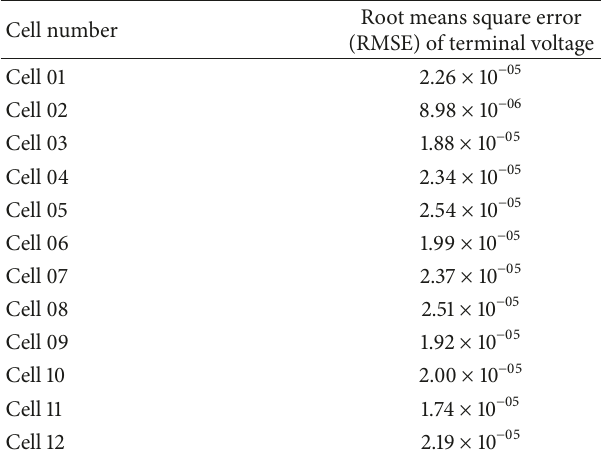
Table 2: RMSE between simulation and experiment of terminal voltage at 25 ∘